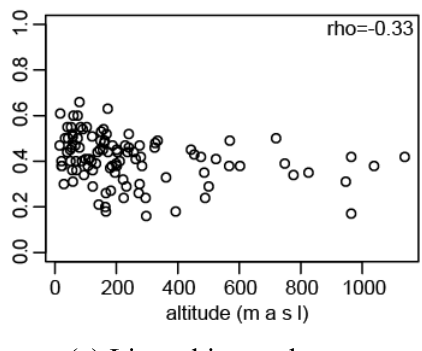
Figure 2. Examples of the significant correlations (Spearman correlation) between model accuracy expressed as true positive rate and geographical properties of study